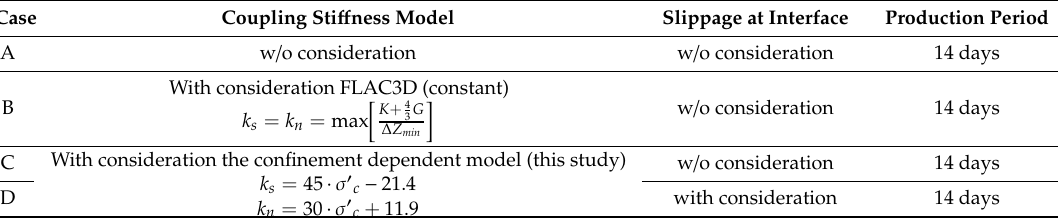
Table 4. Comparison of cases for parametric analysis.